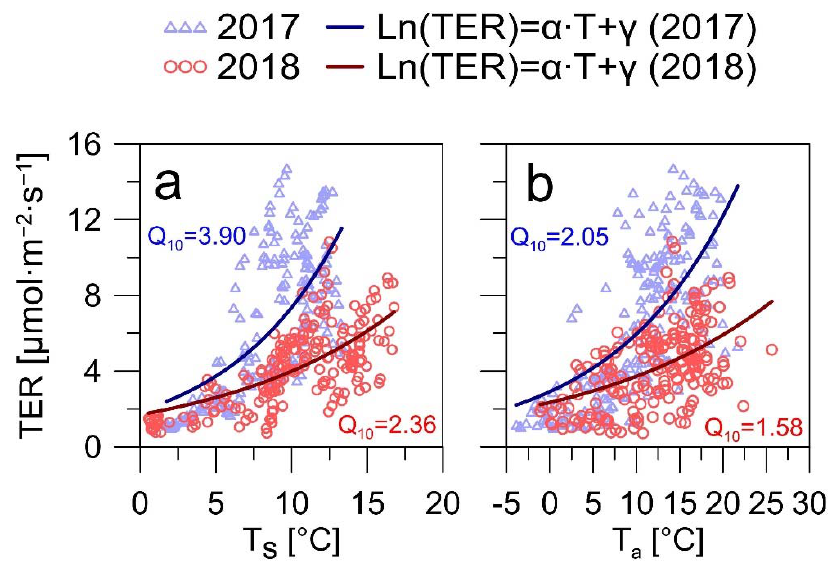
Figure 5. The dependence of the mean night-time total ecosystem respiration (TER) in the nemorose spruce forest on the mean night-time ( a ) soil (T s ) and ( b ) air (T a ) temperatures obtained in the period 01 May to 31 October 2017 and 2018 at the site approximated by the Q 10 model (Equation (2)). Table 5. Parameters α and γ (Equation (2)), coefficient of determination (R 2 ) of the approximation (Figure 5), and Q 10 and R 10 parameters calculated from the derived curves ( p < 0.001). R 10 α γ R 2 Q 10 (µmol ∙ m − 2 ∙ s − 1 )